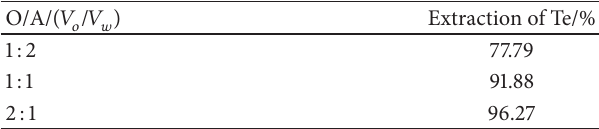
Table 5: Effect of the volume phase ratio on Te(IV) extraction.